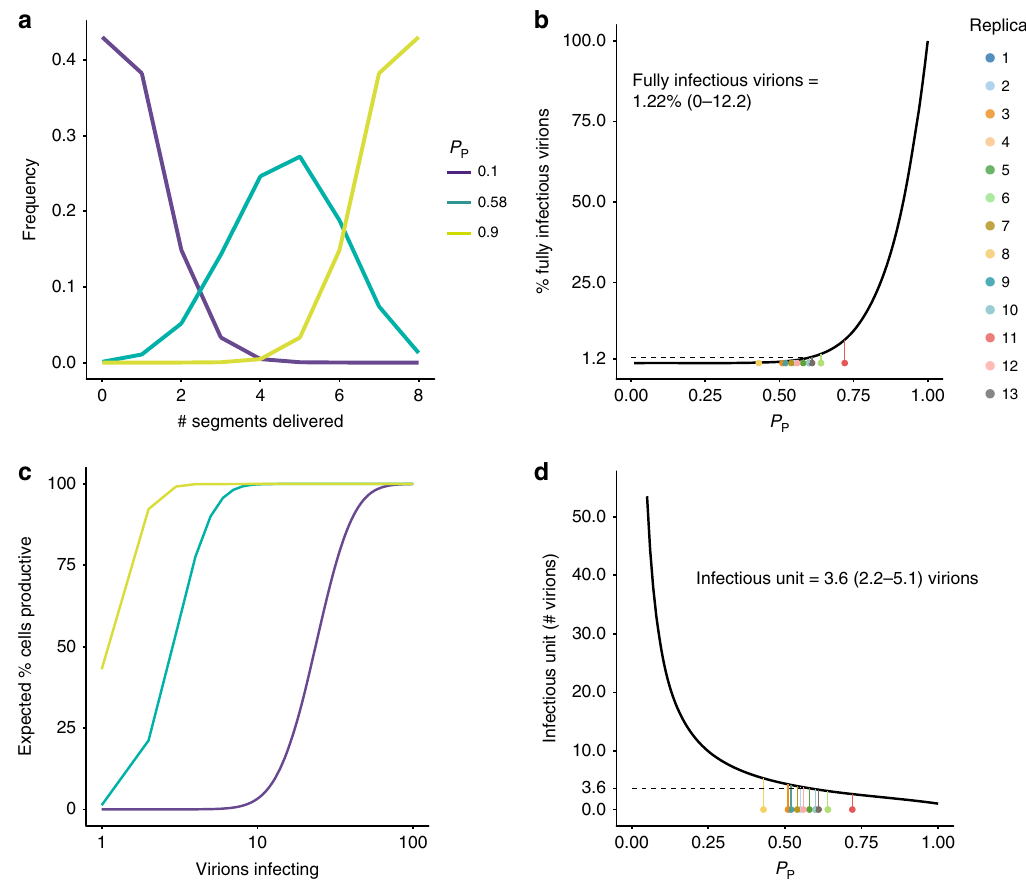
Fig. 2 Incomplete genomes require complementation for productive infection at the cellular level. a The expected number of segments delivered upon infection with a single virion was calculated for two extreme values of P P (0.10, 0.90) and the estimated P P of Pan/99 virus (0.58, mean ±SD 0.50 – 0.64). b The percentage of virions expected to initiate productive infection was plotted as a function of P P . Colored points along the bottom of the plot correspond to the average P P value of each experimental replicate in Fig. 1, with lines connecting them to their predicted value on the theoretical line, and therefore represent predicted frequencies for Pan/99 virus. Mean±SD (given by Eqs (8) and (9)) interval is given in the text above the line. c The percentage of cells expected to be productively infected following infection with a given number of virions was calculated for the same P P values as in ( a ). d The expected number of virions required to make a cell productively infected is plotted as a function of P P . As in ( b ), colored points correspond to the average P P value of each Pan/99 experimental replicate in Fig. 1, and mean ±SD (given by Eqs (13) and (14)) interval is given in the text. Source data are provided as a Source Data fi